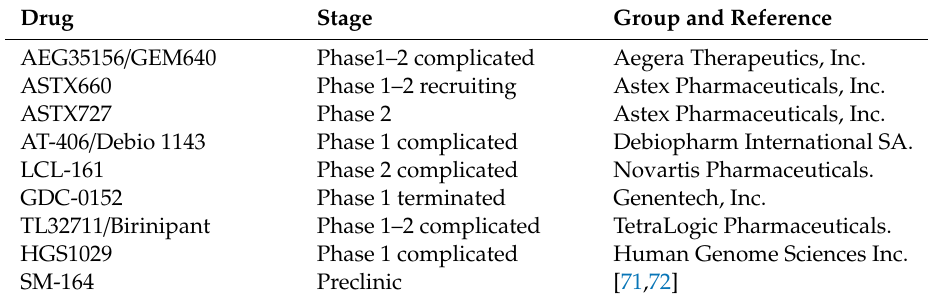
Table 2. The research progression on XIAP-related drugs. Data are summarized according to